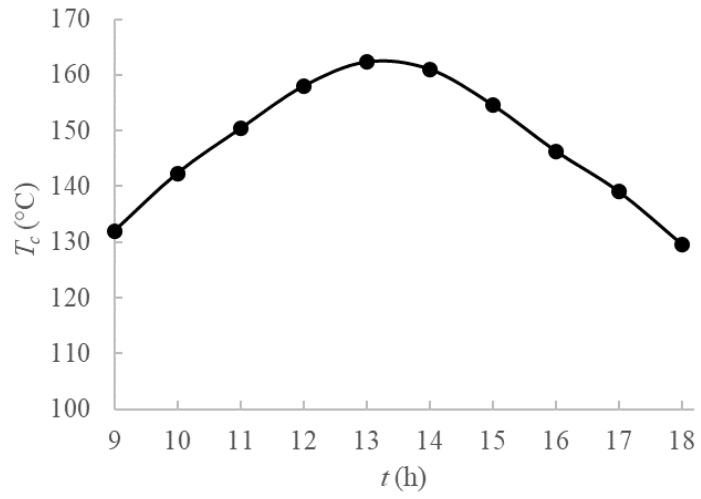
Figure 2. Temperature profiles during the day for Tunisia heat source [25].